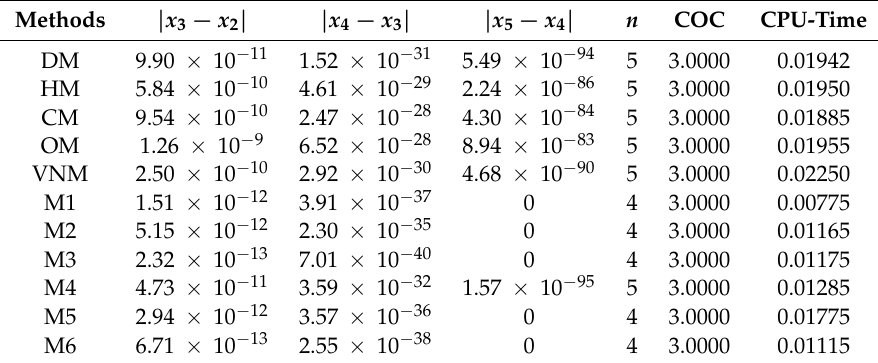
Table 1. Comparison of performance of methods for Example